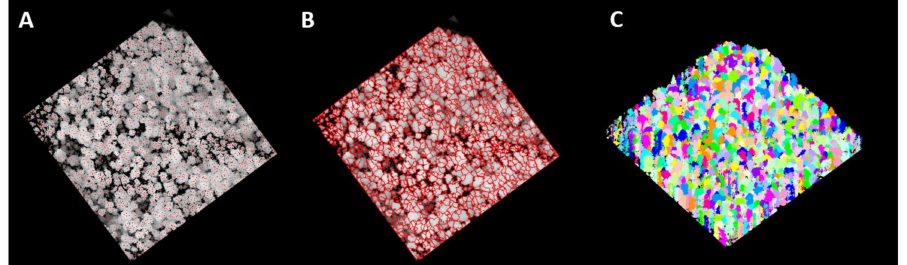
Figure 7. Summary of SEGMA main steps applied on the 1 ha (+ buffer) ULS-V rasterized CHM (ULS-V-Raster): ( A ) pit-free CHM at 25 cm resolution and initial identification of local maxima; ( B ) filtering of local maxima and watershed delineation of individual tree crowns; and ( C ) top to bottom delineation of individual trees in the point